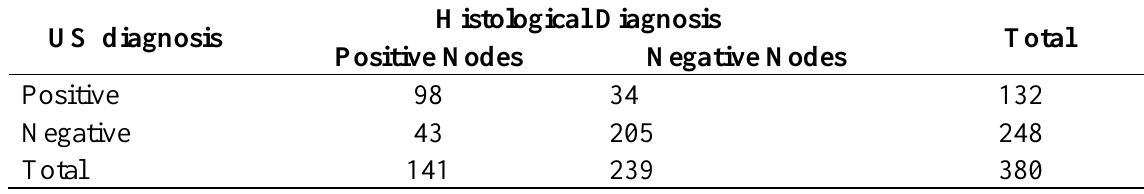
Table 1. Diagnostic accuracy of ultrasound in detecting axillary lymph nodes with